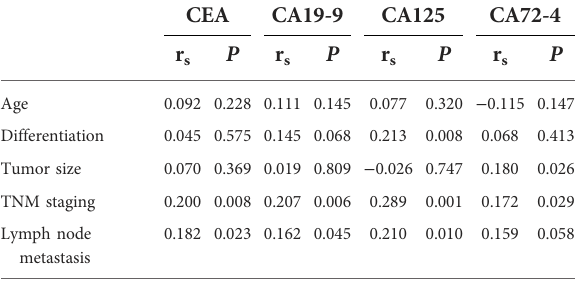
TABLE 6 Multivariate analysis (Cox proportional hazard model) of prognostic